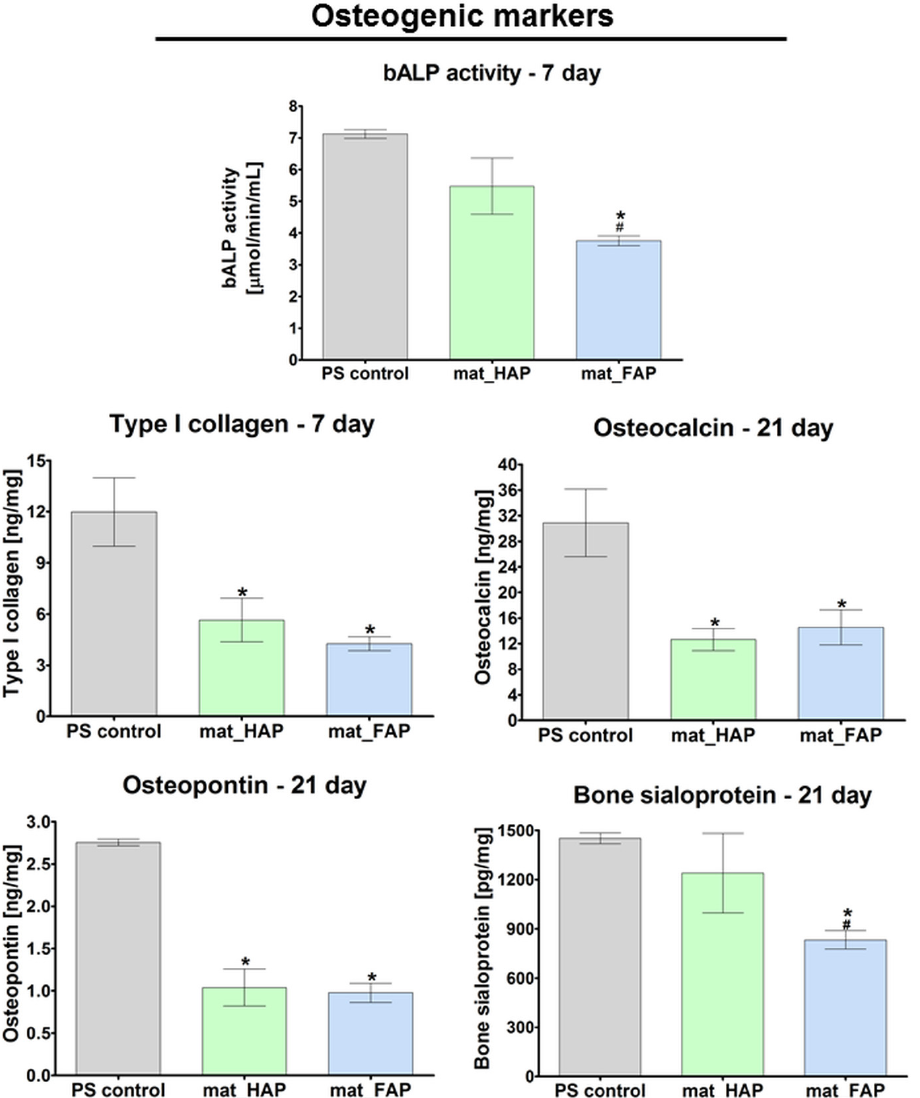
Figure 5. The level of osteogenic markers (bALP, type I collagen, bone sialoprotein, osteocalcin, and osteopontin), assessed by enzyme-linked immunosorbent assays (ELISAs) in human foetal osteoblasts (hFOB 1.19), grown on the biomaterials (PS control—cells cultured in the polystyrene wells; * statistically significant results compared to PS control, # statistically significant results compared to mat_HAP, p < 0.05, one-way ANOVA followed by Tukey’s test). ELISA did not reveal statistically significant results in the level of Col I production between the samples, which was confirmed by CLSM images, that presented great depos- its of Col I protein on the surface of both biomaterials after 21 days of culture (Figure 6). Late markers of osteogenic di ff erentiation (BSP, OC, and OPN) were evaluated in hFOB 1.19 cells, after 21 days of culture on the surface of the fabricated biomaterials (Figure 5).